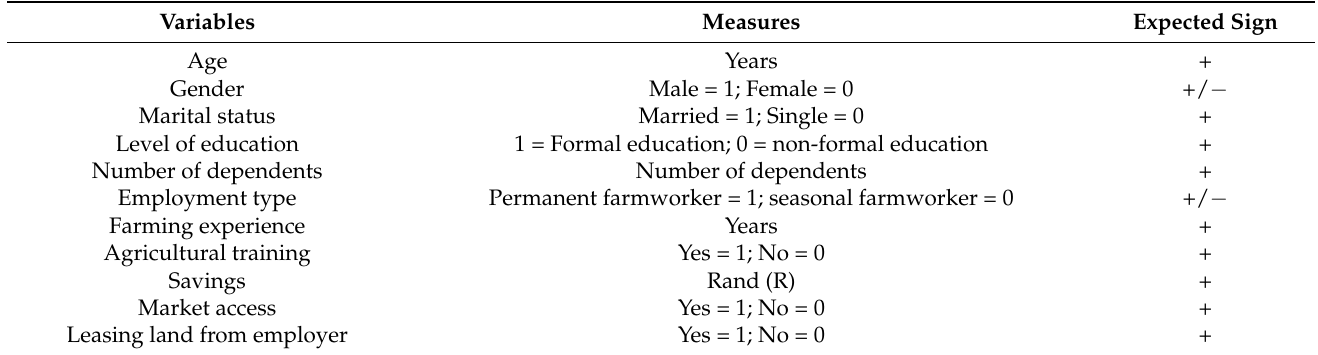
Table 2. Description of independent variables used in the binary probit regression model and the multinomial logistic regression